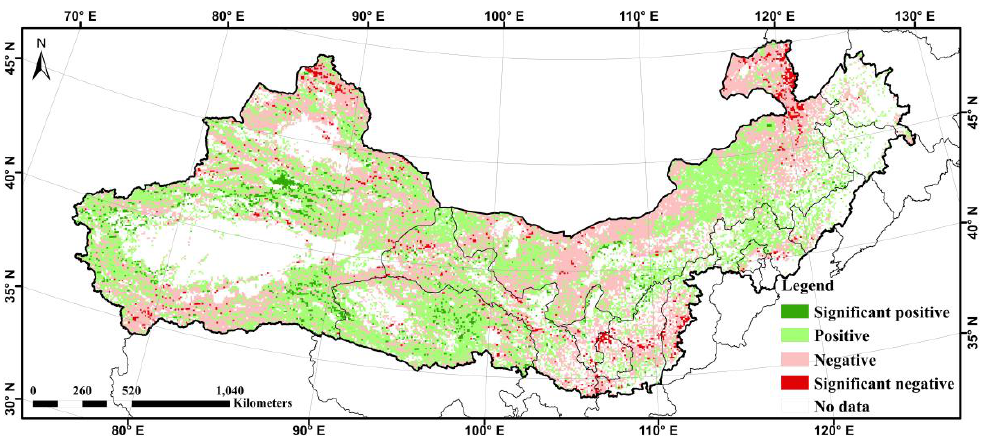
Figure 6. Significant correlation between the accumulated NDVI and annual mean temperature from 1982–2006. Table 2. Statistics of significant correlation between the accumulated NDVI and annual mean temperature.